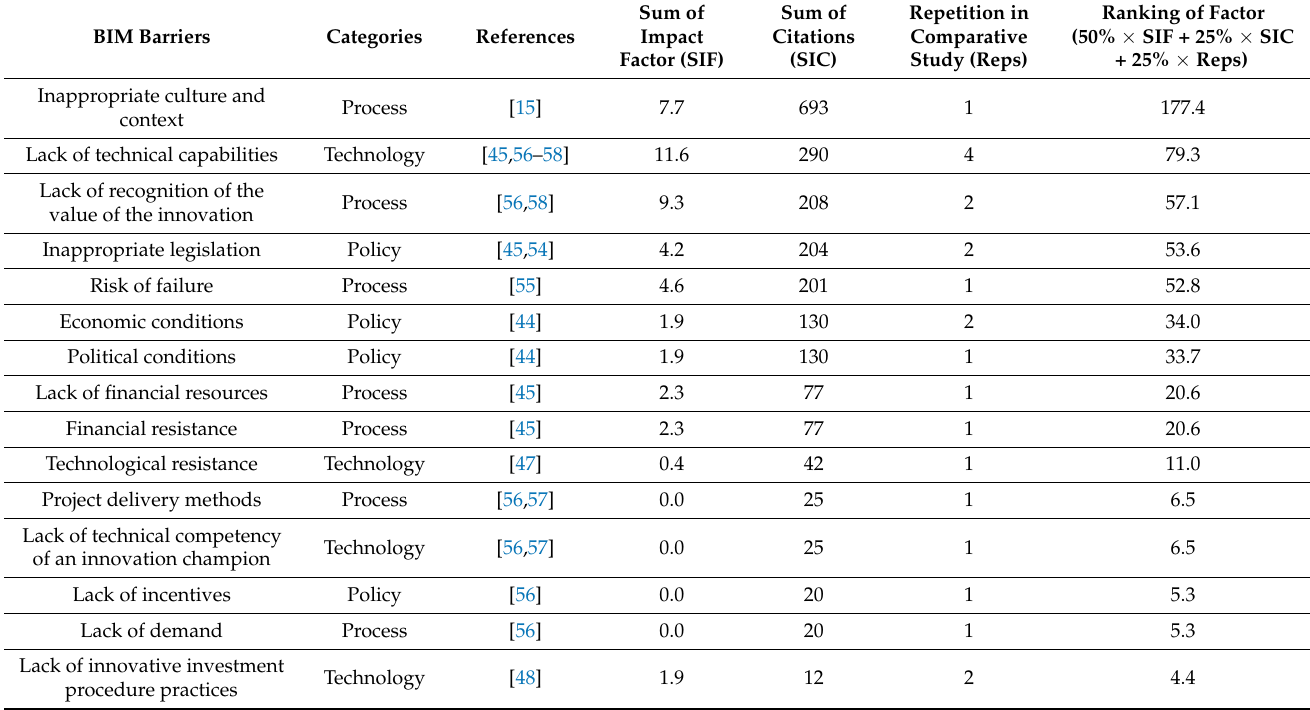
Table 9. Scores and ranks of BIM innovation barriers in developing countries.